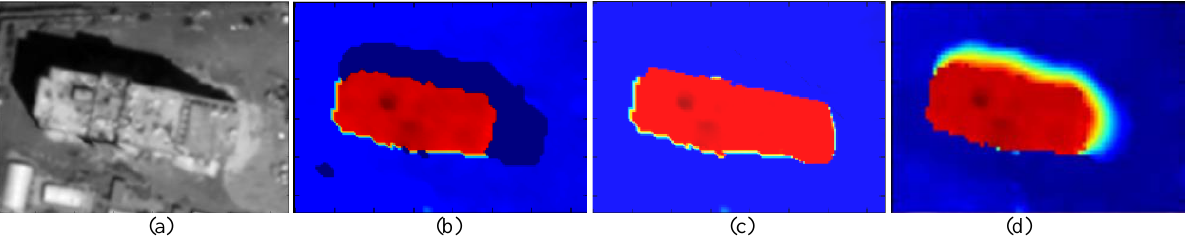
Figure 11. A building in the image (a), in the unfilled DSM (b), in the result DSM (c), in the given DSM, comparison between (c) and (d) shows the effect of using spectral information to fill the